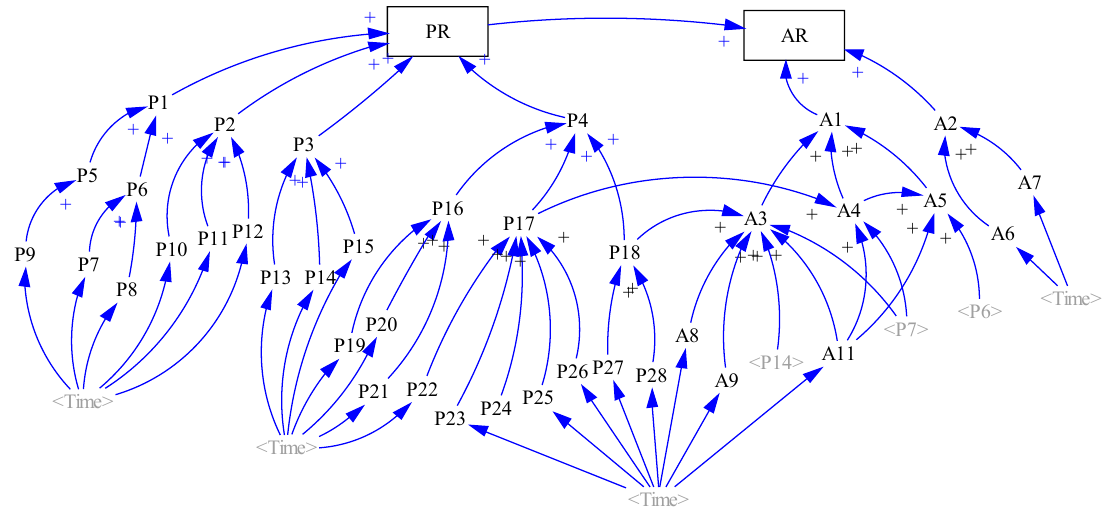
Figure 5. Coupling model flow diagram, for example, V3: AR–PR.